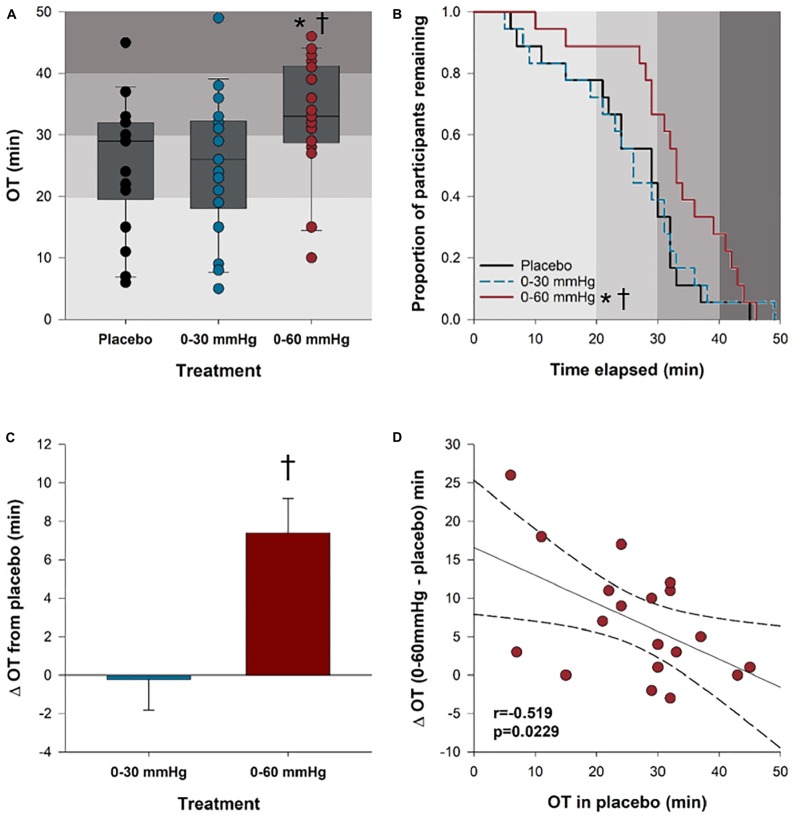
Orthostatic tolerance. (A) Orthostatic tolerance, rounded to the nearest minute, is shown for all three tilt conditions. (B) Kaplan–Meier plot depicting the proportion of participants remaining (who have not reached presyncope) in each condition at any given tilt time. (C) Bar plots showing the mean improvement in orthostatic tolerance for each compression condition relative to the placebo. (D) The mean improvement in orthostatic tolerance with 0–60 mmHg compression compared to placebo was dependent on baseline orthostatic tolerance (placebo). ∗Significantly different from placebo (p < 0.05); †significantly different from 0 to 30 mmHg compression (p < 0.05). Shaded gray boxes of increasing intensity represent stages of the tilt test and increasing orthostatic stress. OT, orthostatic tolerance.